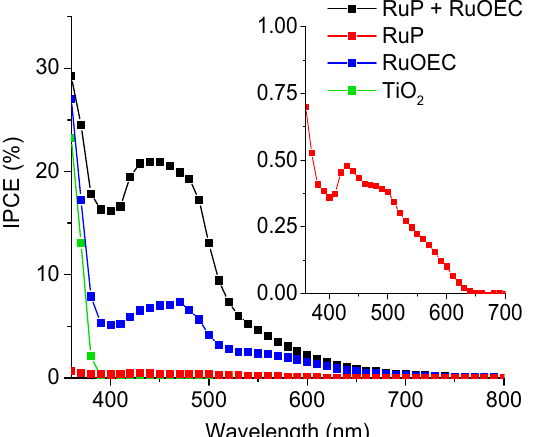
Figure 2. Incident photon-to-current efficiency (IPCE) spectra of selected water splitting systems with pure TiO 2 and sensitized with RuP, RuOEC, or RuP + RuOEC. The electrolyte is HCl (pH ≈ 3). The inset shows an enlarged IPCE spectrum of TiO 2 sensitized with RuP. The IPCE spectra were calculated based on the photocurrents measured within two seconds after switching the light on.